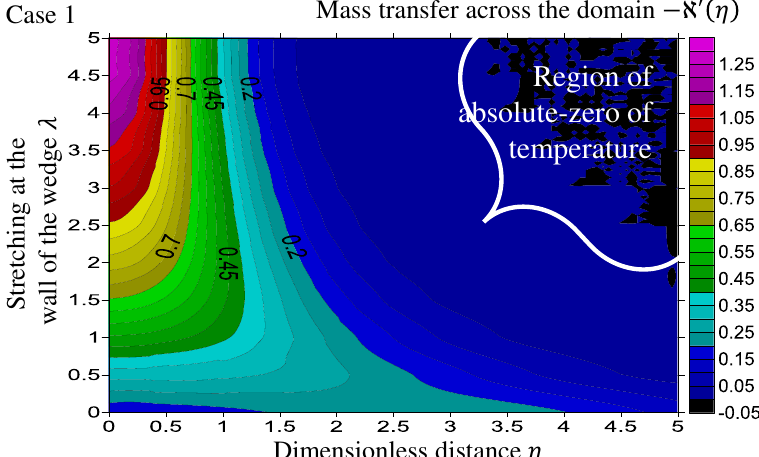
Dimensionless distance (cid:1) Figure 8. Variation of the heat transfer − θ (cid:48) ( η ) with the wall stretching velocity λ —case 2.